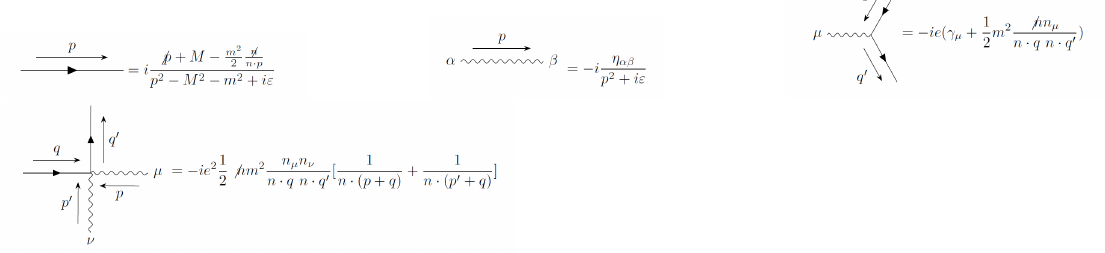
Figure 1. Feynman rules for one loop computations: electron and photon propagators, A µ ee and A µ A ν ee